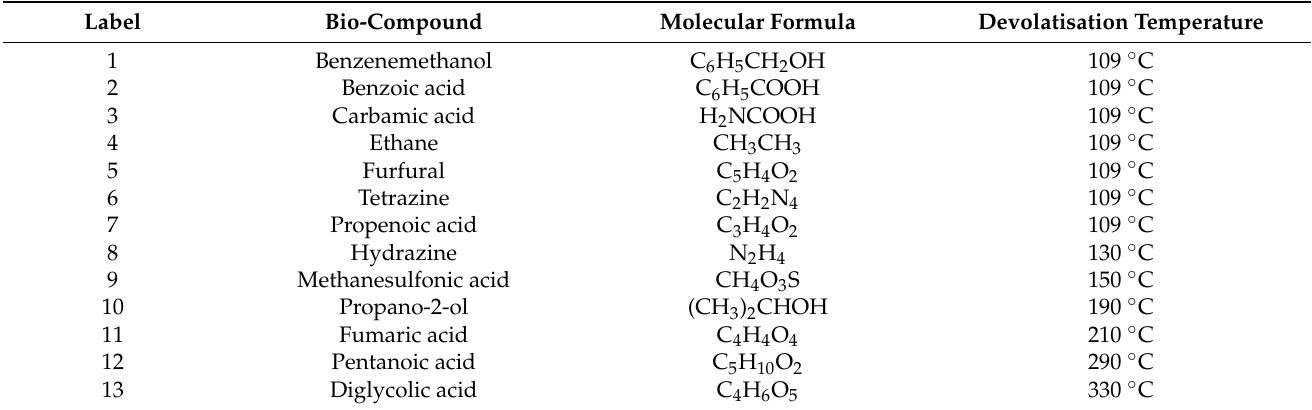
Table 5. Volatile compounds detected during the pyrolysis of the GC/MS analysis of the Mexican Caribbean macroalgae consortium sample (A3).